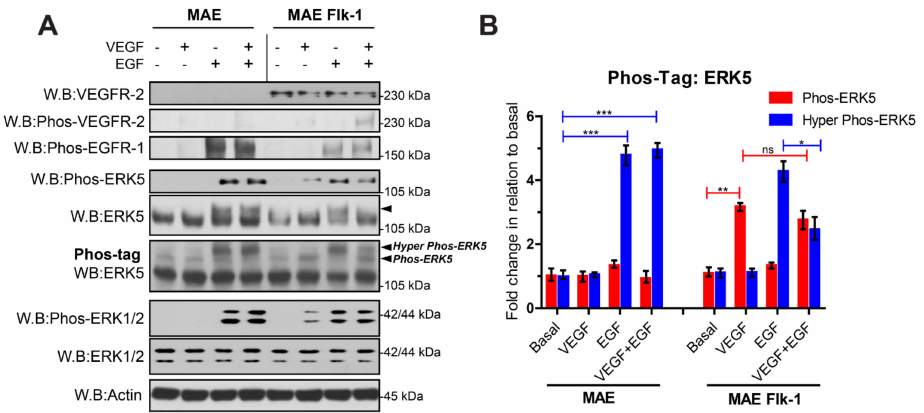
Figure 4. Analysis of EGFR-1- and VEGFR-2-mediated ERK5 activation in murine endothelial cells. ( A ) Murine Aortic Endothelial (MAE) cells or MAE-expressing Flk-1 were serum-starved overnight and stimulated with either VEGF (50 ng/mL), EGF (50 ng/mL) or both VEGF (50 ng/mL) + EGF (50 ng/mL) for 10 min. Cells were lysed in RIPA buffer, and lysates were resolved by SDS-PAGE or Phos-tag SDS-PAGE and analysed by Western blotting. ( B ) Quantification of ERK5 level by densitometric analysis. Data are shown as mean fold change relative to basal normalised to Actin level ± SEM ( n = 3). Statistical analysis: one-way ANOVA followed by Tukey’s post hoc test, where * p < 0.05, ** p < 0.01, *** p < 0.001, ns = not